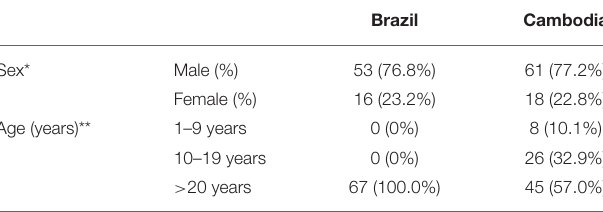
TABLE 1 | Main demographic characteristics of study participants in Brazil and